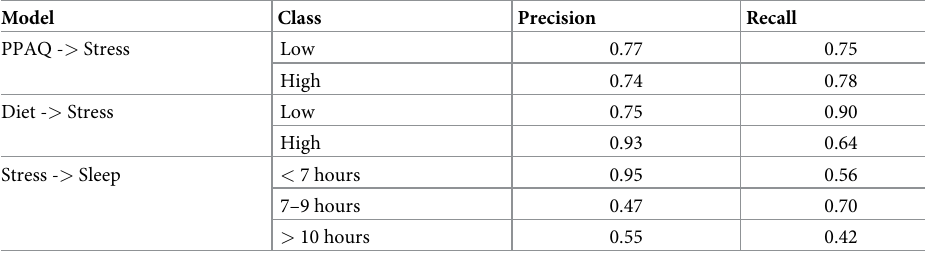
Table 5. Evaluation of each model in terms of precision and